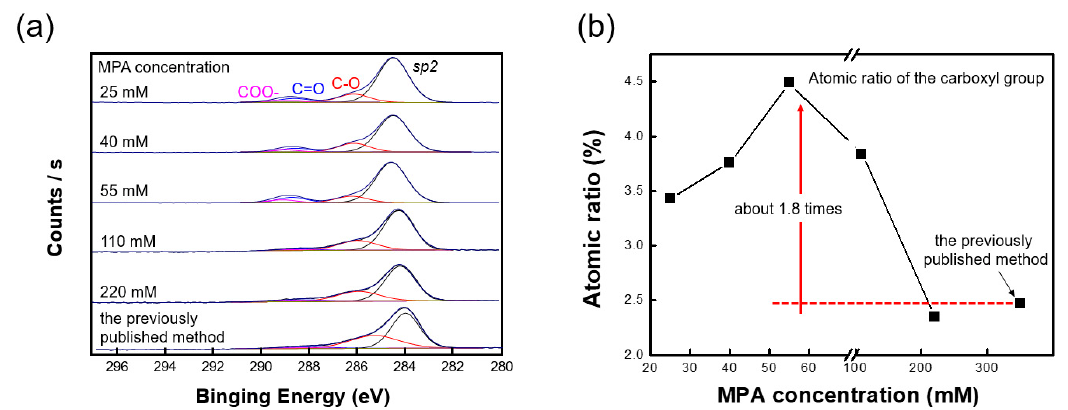
Figure 5. ( a ) C 1s deconvolution curves and ( b ) atomic ratios of films treated with different MPA concentrations. The MPA concentration was optimized at 55 mM. The MoS 2 film treated at the optimized concentration had 1.8 times more carboxyl groups than the film prepared by the previously reported strategy.